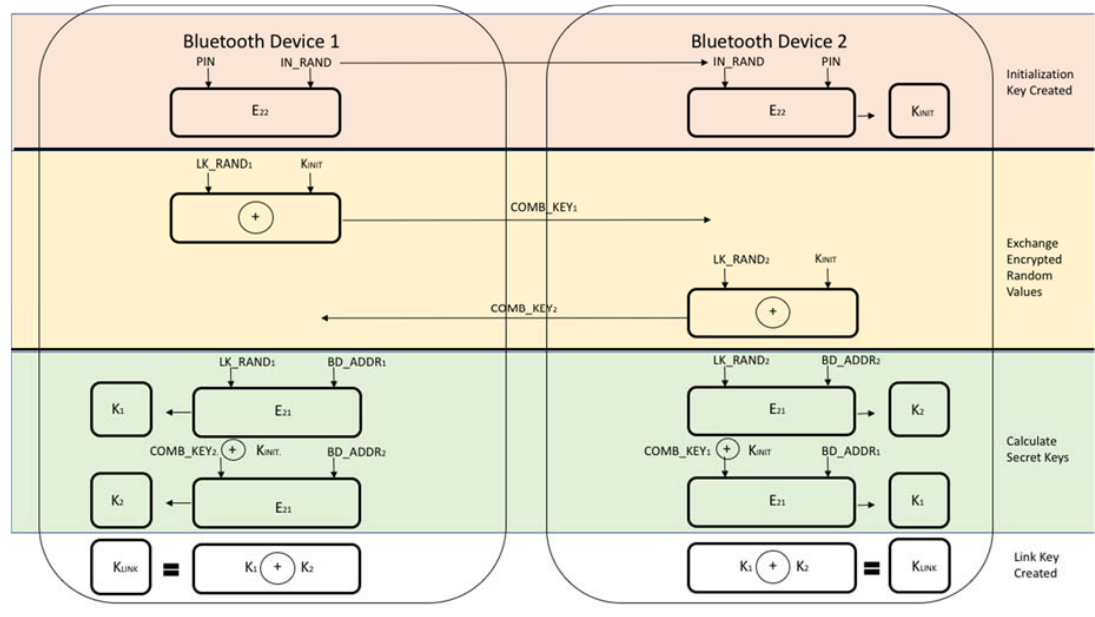
Figure 4. Link-Key Generation with PIN.